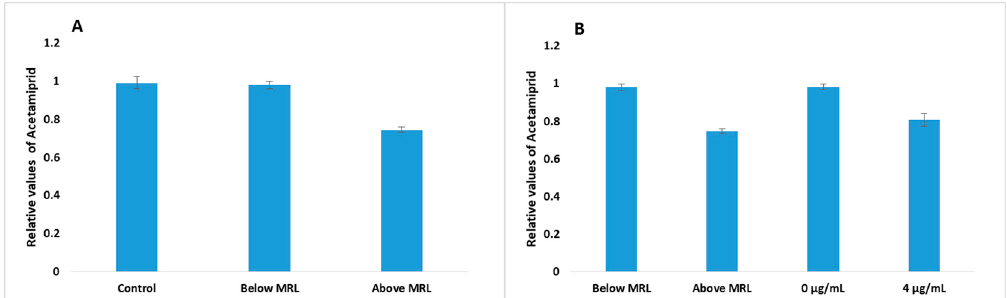
Figure 4. ( A ) Average of relative values from the database after processing with the algorithm. 480 time − series with Above MRL samples and 492 time − series with Below MRL samples and Control samples were used to build the database. ( B ) Comparison of relative values from lettuce extracts with known concentrations of acetamiprid, after processing with the algorithm, with the Above and Below MRL values from the database (128 time − series).